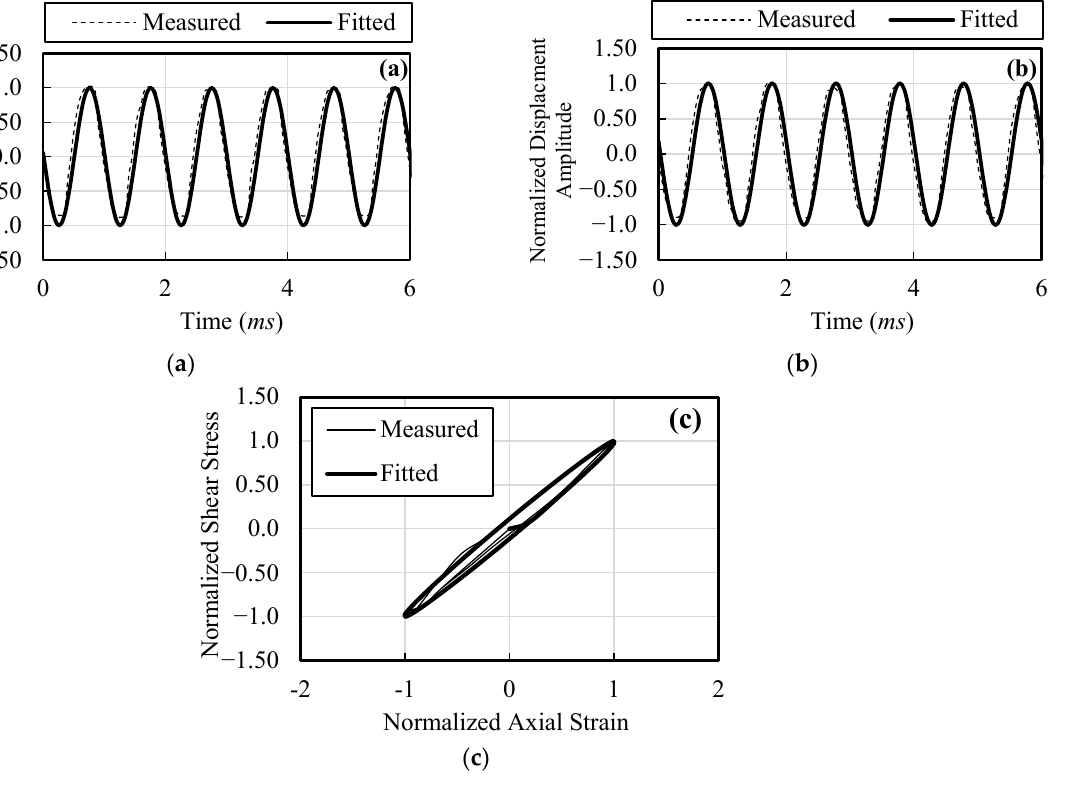
Figure 5. Typical matching of normalized signals and loops from CT tests. ( a ) Stress amplitude; ( b ) Displacement amplitude; ( c ) Hysteretic loops